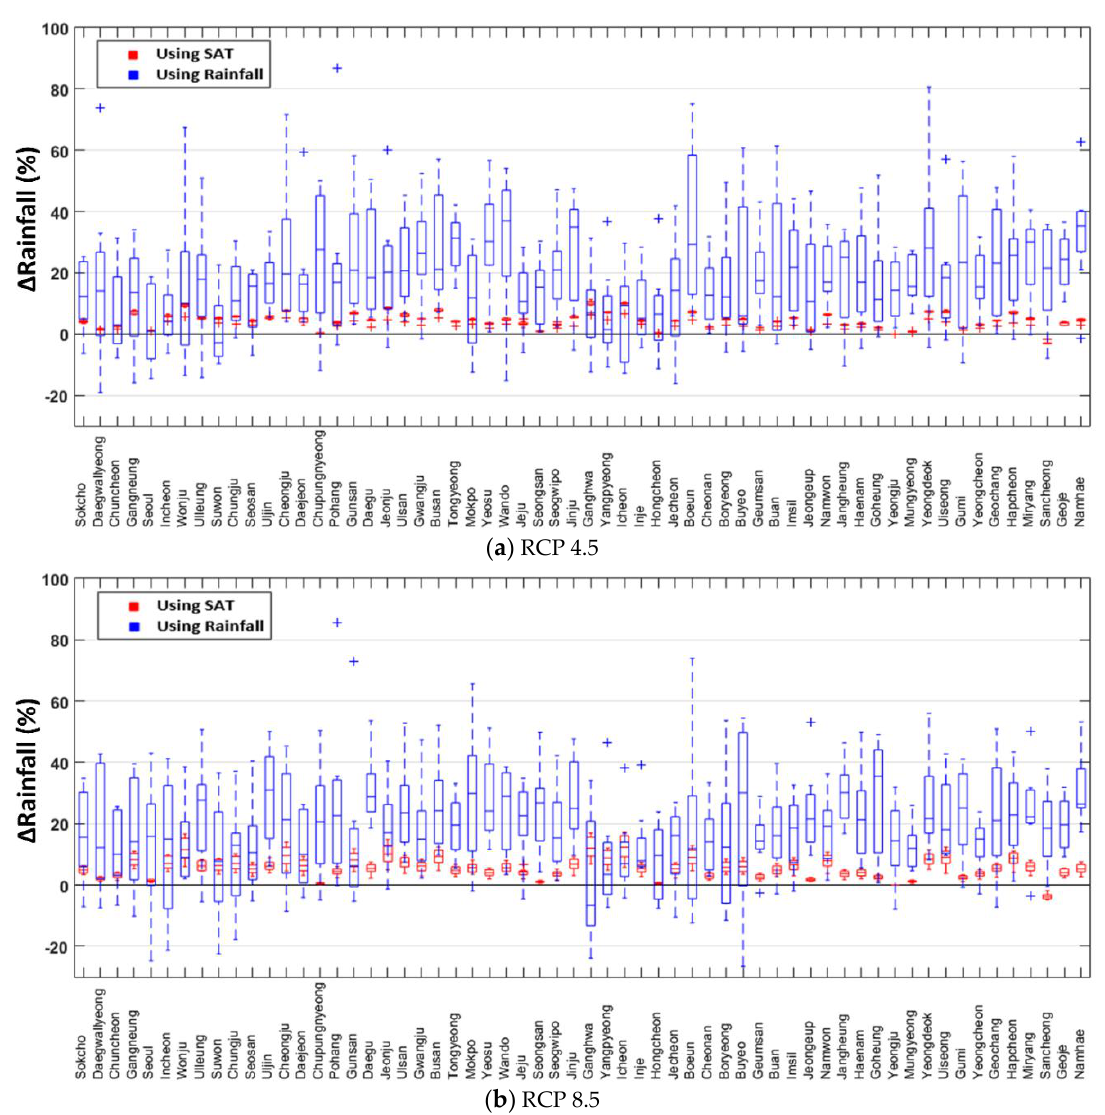
Figure 16. Change rate of future annual exceedance daily rainfall depth using SAT and rainfall data.